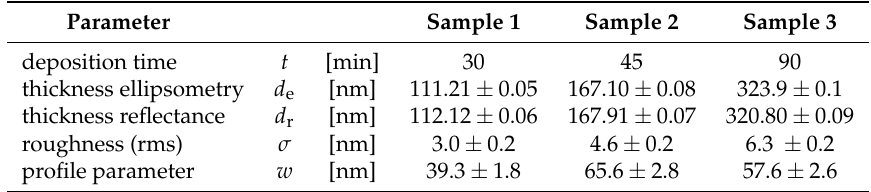
Table 2. The values of the structural parameters.